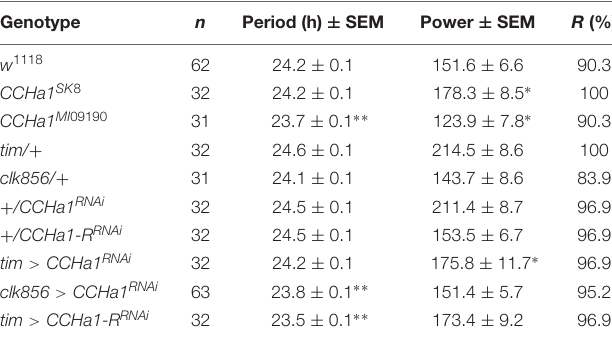
TABLE 1 | Free-running activity rhythms in